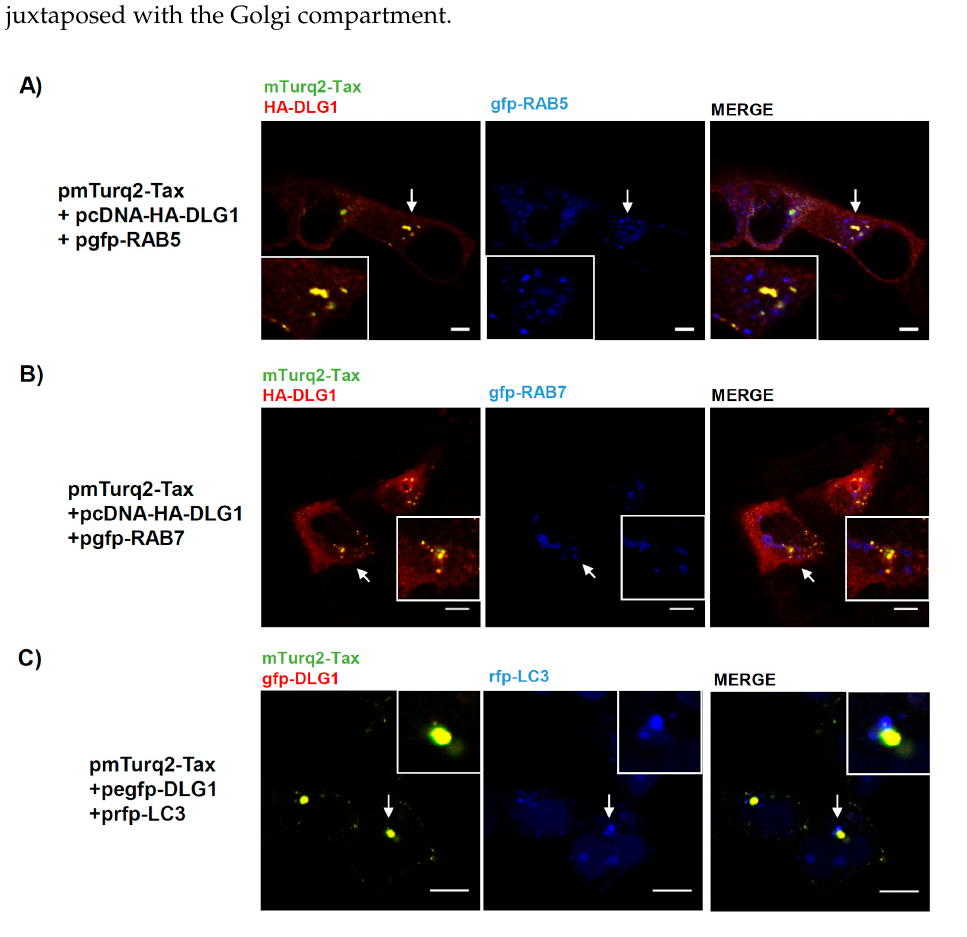
Figure 4. The DLG1-Tax complexes do not co-localize in endosomes or autophagosomes. ( A and B ) Evaluation of co-localization between the DLG1-Tax complexes and endosomal markers. HEK293 cells were transiently transfected with pcDNA-HA-DLG1 (HA, human influenza hemagglutinin epitope) and pmTurq2-Tax plasmids, along with a pgfp-RAB5 ( A ) or pgfp-RAB7 ( B ). The HA-DLG1 expression was detected by immunofluorescence using an anti-HA antibody. The DLG1-Tax co-localization pattern is shown in yellow and RAB expression is shown in blue; ( C ) Assessment of co-localization between the DLG1-Tax complexes and the autophagosome marker LC3. The prfp-LC3 plasmid was transfected in HEK293 cells along with both pmTurq2-Tax and pegfp-DLG1 plasmids. Each protein expression was observed by direct emission of the tagging fluorescent proteins. The DLG1-Tax colocalization pattern is shown in yellow and LC3 expression is shown in blue. In ( A – C ) the white arrow indicates the region magnified in the inset. All scale bars represent 10 µm.